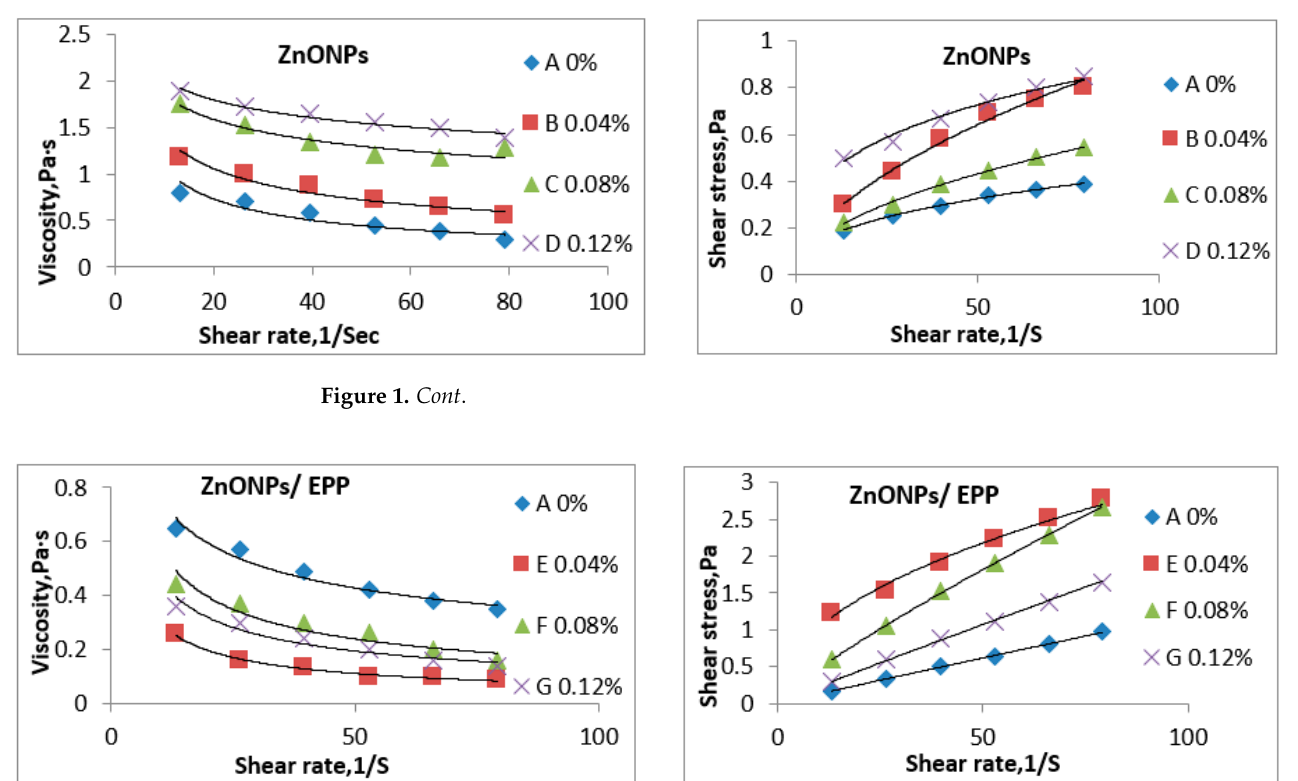
Figure 1. Shear rate, shear stress, and viscosity of nanoedible film to produce an edible film-forming suspension solution of different treatments.